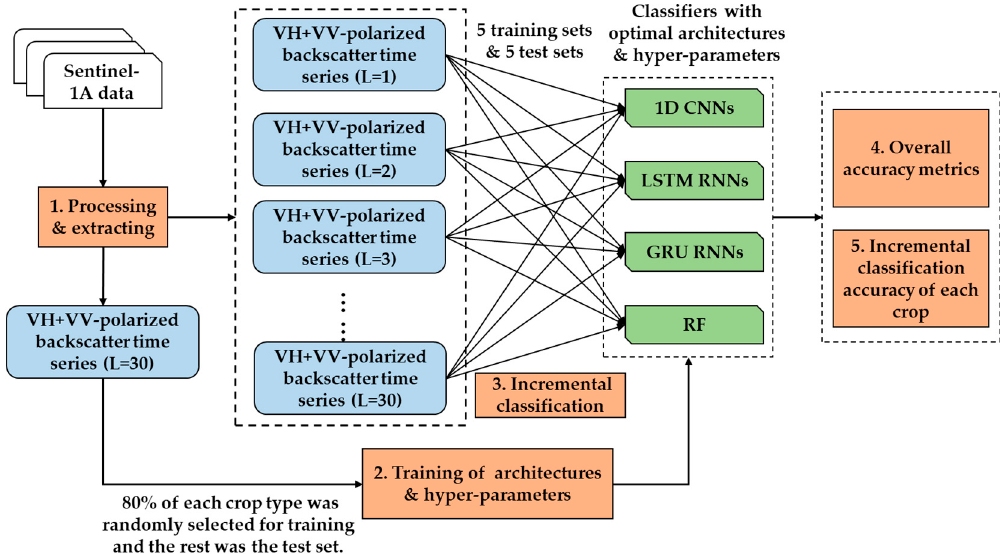
Figure 2. Methodology used in this study. L refers to the length of the time series.